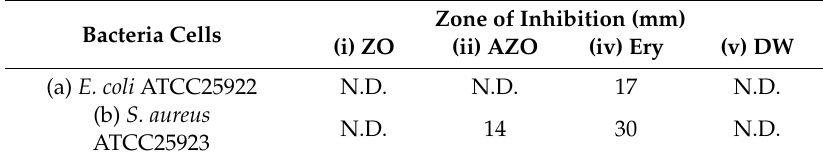
Table 1. Zone of inhibition (ZOI) diameter of ZO and AZO samples against (a) E. coli and (b) S. aureus was measured from n = 3 and representative data are shown.